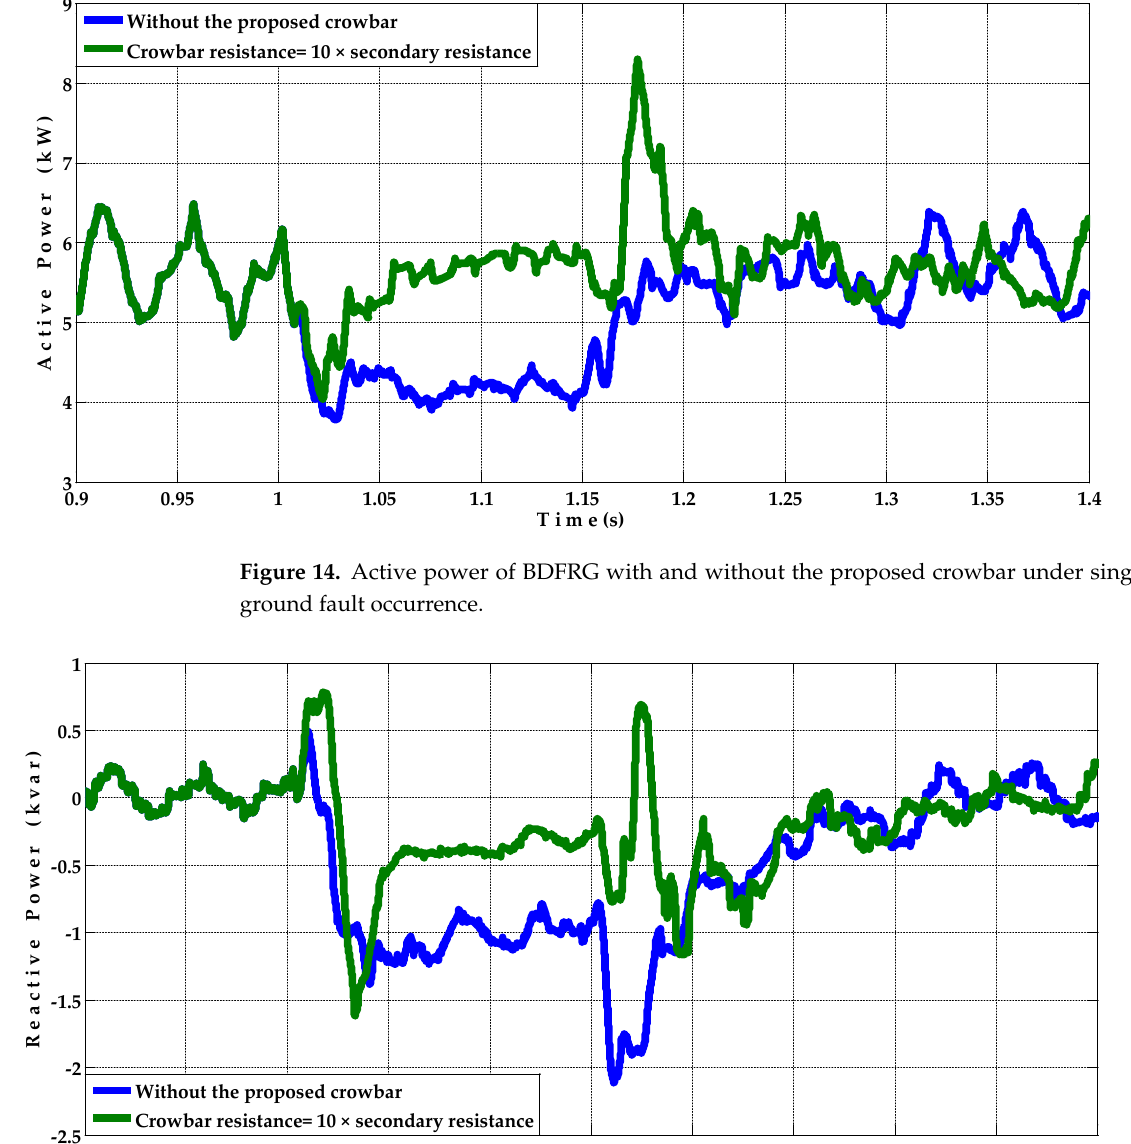
Figure 15. Reactive power of BDFRG with and without the proposed crowbar under single-line to ground fault occurrence.